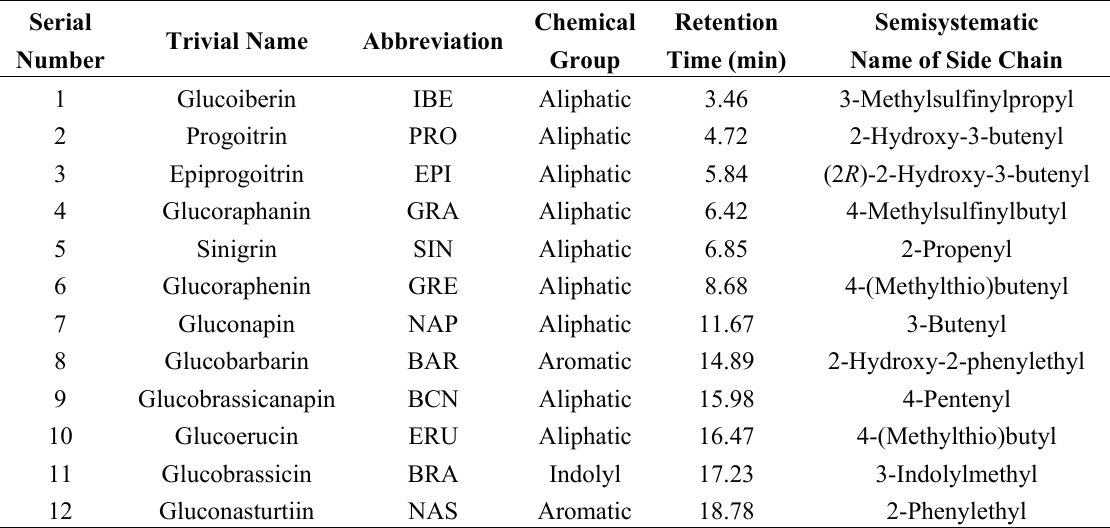
Table 1. UPLC spectroscopy information on 12 identified major desulfo-glucosinolates studied in nine Brassica